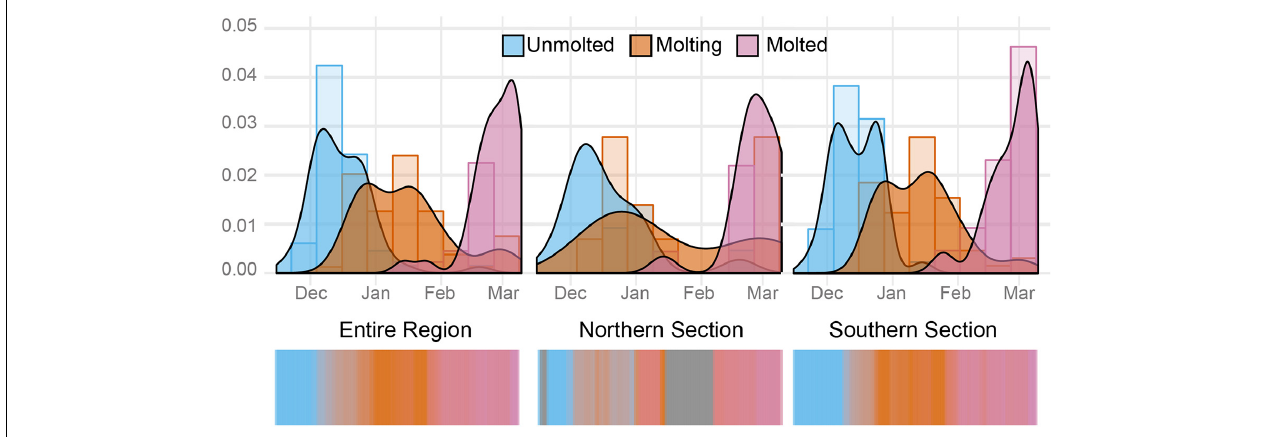
FIGURE 6 | The seasonal progression of Weddell seal molt. Histogram data in 12-day bins, and kernel density estimates for each stage. The northern region lies north of 63.5 ◦ S while the southern region lies south of this latitude.